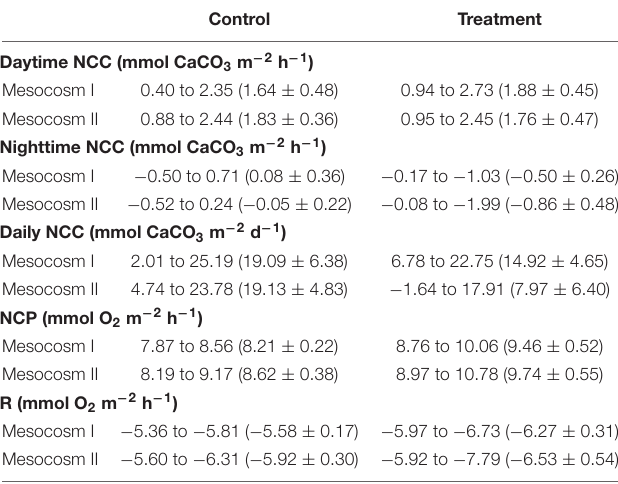
TABLE 3 | Summary of the variation ranges and mean ± standard deviations of the daytime, nighttime, and daily net community calcification (NCC), net community production (NCP), and respiration (R) in the replicate mesocosms over the course of the control and treatment periods.